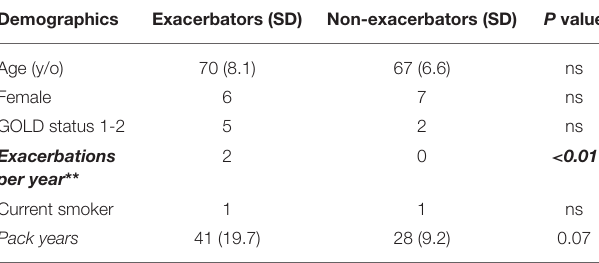
TABLE 2 | Survey responses regarding potential IAP generating